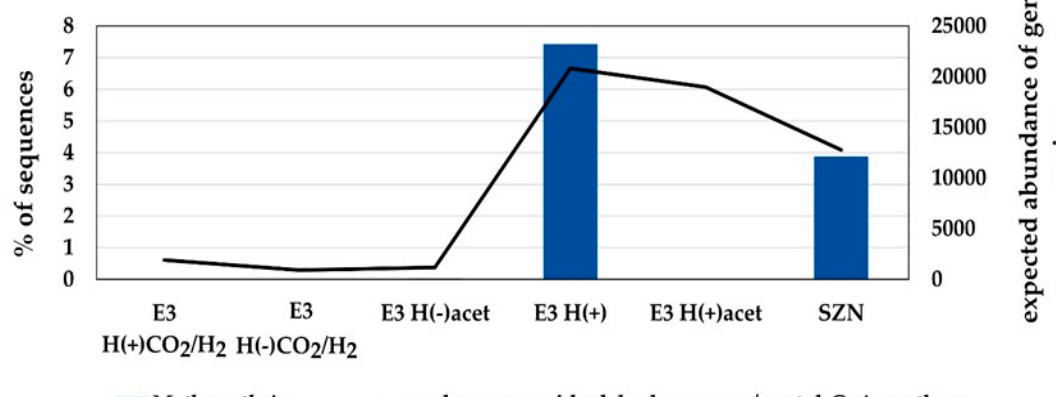
Figure 6. Relative contribution of Methanothrix and acetogenic bacteria (the latter presented as KEGG- revealed expected abundances of genes responsible for the synthesis of enzymes involved in the acetate-generating Wood–Ljungdahl pathway - carbon monoxide dehydrogenase [EC